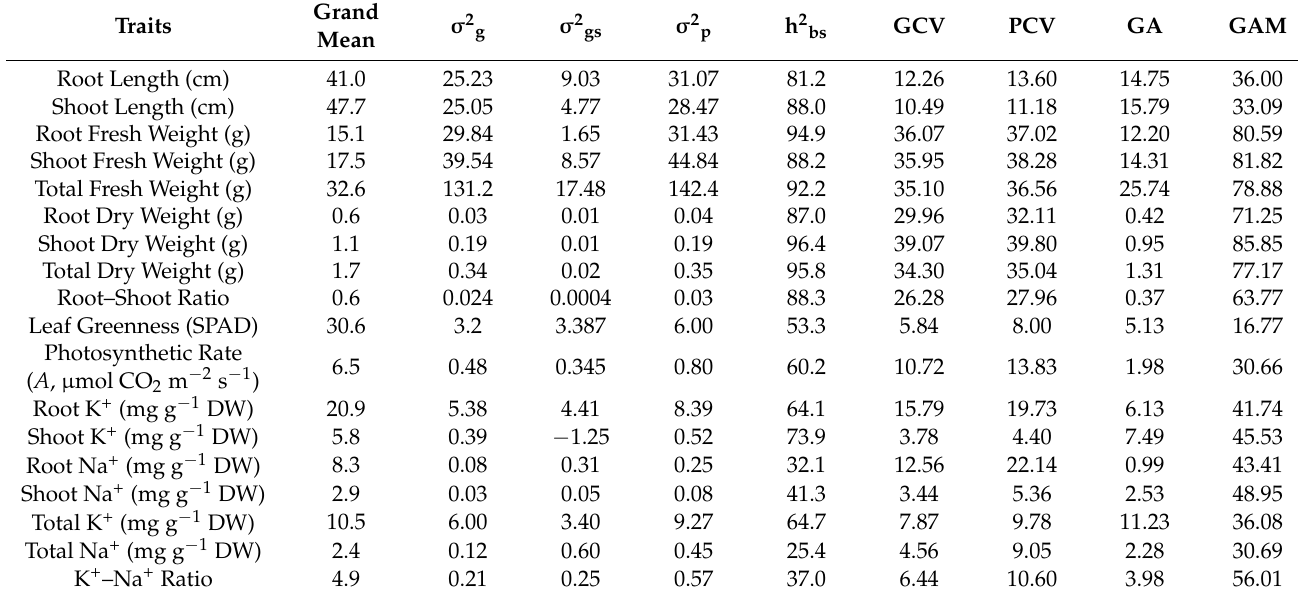
Table 3. Estimates of variance components, heritability, genotypic and phenotypic coefficients of variance, genetic advance and genetic advance as percent of the mean for 18 maize cultivars grown under two salinity